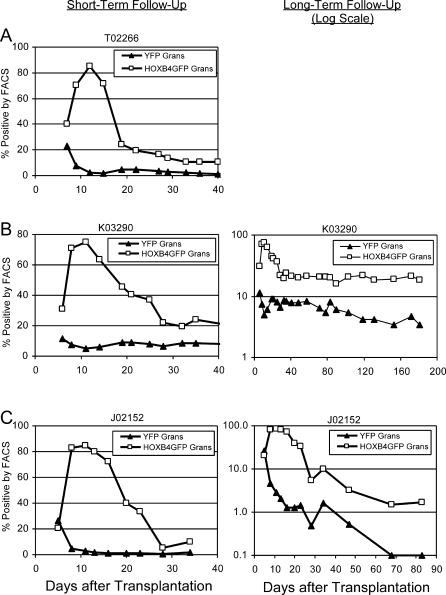
Improved Engraftment of HOXB4GFP-Transduced and HOXB4GFP-Expanded CD34
+ Cells
Equal numbers of macaque CD34
+ cells were transduced in 3-d transduction cultures with either the HOXB4GFP or YFP vector and then cultured for an additional 9 d (T02266) or 6 d (K03290 and J02152) in the presence of SCF, TPO, Flt-3L, and G-CSF. All the transduced and expanded cells were infused into myeloablated animals. The percentage of HOXB4GFP
+ and YFP
+ granulocytes was assessed by flow cytometry. Shown is the engraftment of HOXB4GFP
+ and YFP
+ granulocytes after transplantation. (A) T02266, (B) K03290, and (C) J02152.